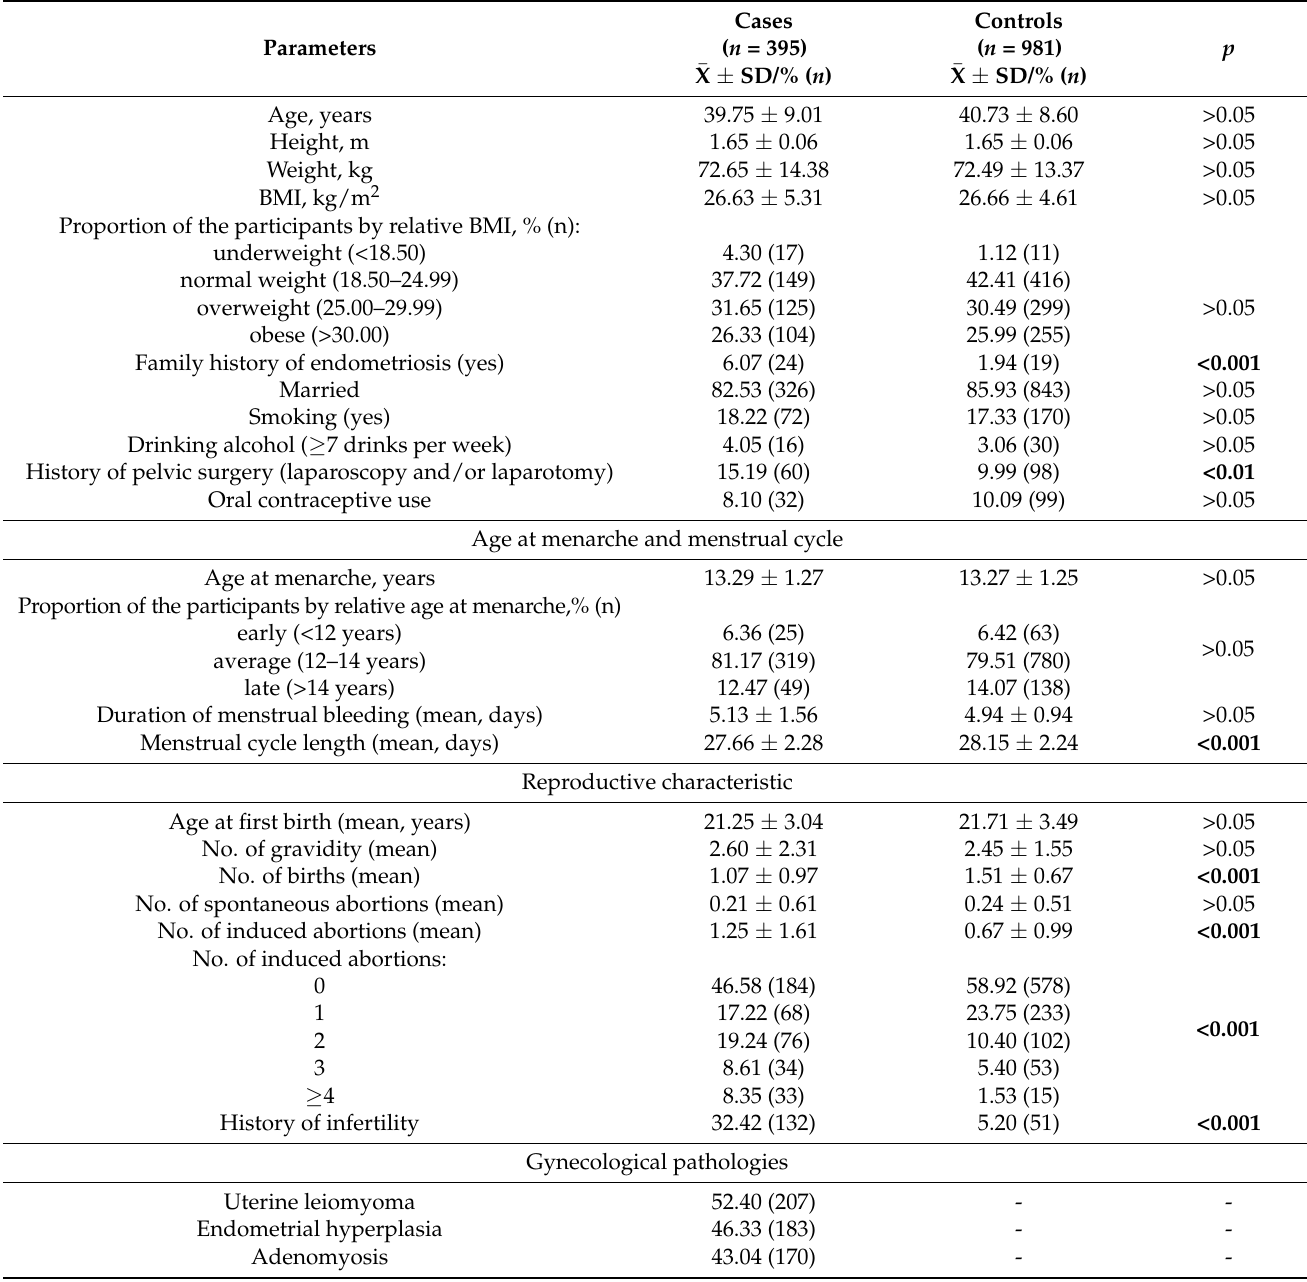
Table 4. Characteristics of participants from the case and control